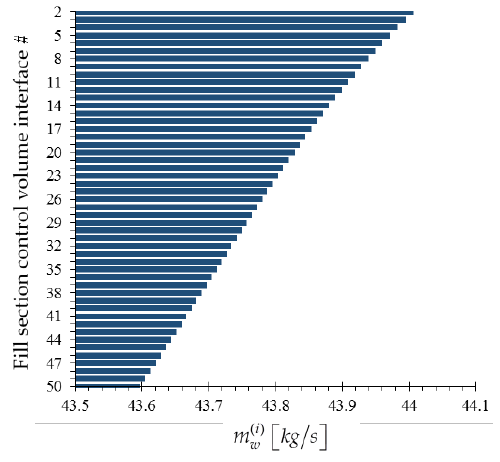
( i ) m , ( 2,...,50)  i , at the exit of each control volume ( i = 2, . . . ,50 ) , at the exit of each control volume m , ( 2,...,50)  i , at the exit of each control volume w m , ( 2,...,50)  i , at the exit of each control volume w , w w